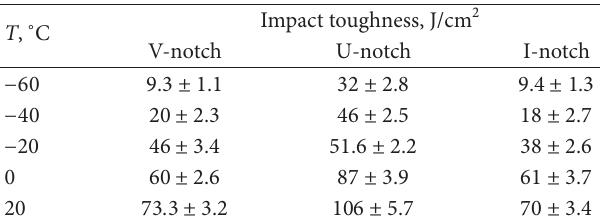
Table 4: Impact toughness test results for 17Mn1Si